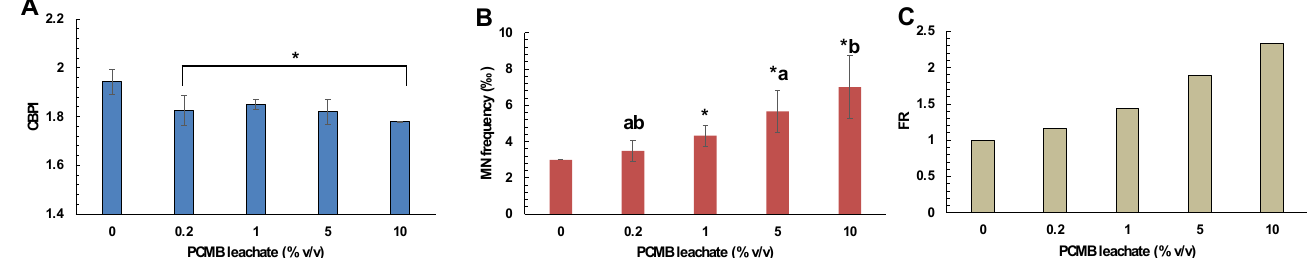
Figure 6. Determination of ( A ) cytotoxic (in terms of CBPI values) and ( B , C ) genotoxic (in terms of MN frequency and frequency ratio) effects of PCMB-DW leachate on human lymphocytes. The results are mean ± SD from 4 different measurements in all cases. Asterisks (*) indicate significant difference from the respective control. Values that share the same letter differ from each other (Mann–Whitney u-test, p < 0.05).